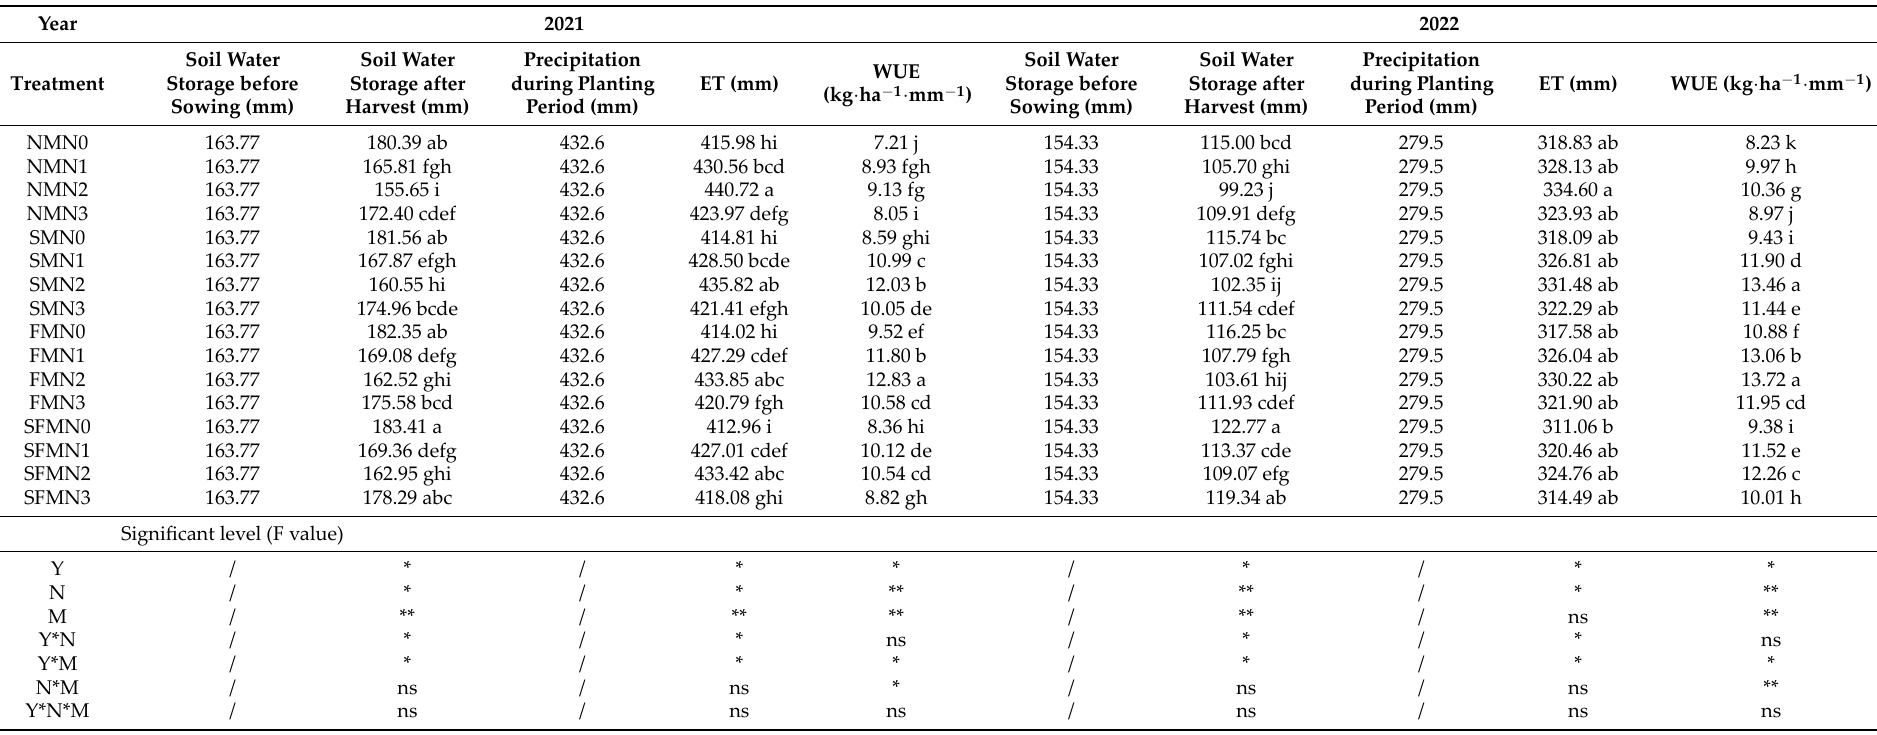
Table 3. Effects of different mulching methods and different nitrogen application on water use efficiency of soybean. The soil water storage before sowing and after harvest was calculated by drilling 0–100 cm soil before sowing and after harvest in each year. The calculation formula is detailed in Liao et al. (2022)